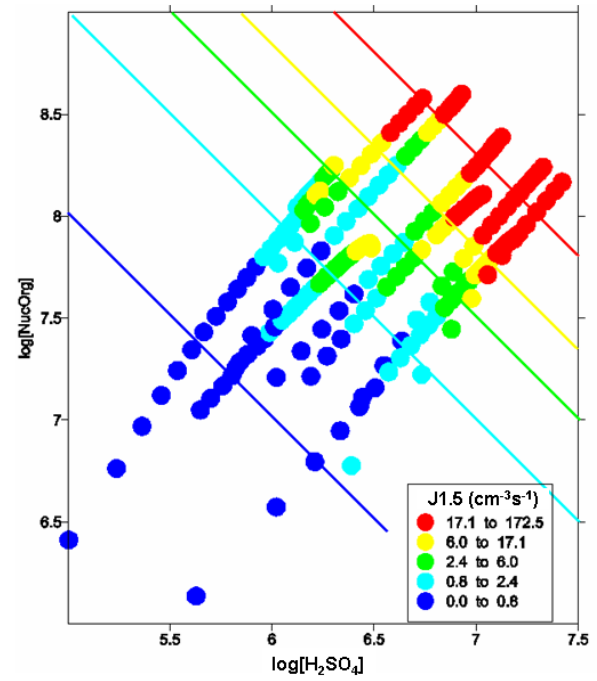
Fig. 5. Heterogeneous nucleation probability curves for the acti- Figure 5. Heterogeneous nucleation probability curves for the activation of differently vation of differently charged tungsten oxide (WO x ) particles with charged tungsten oxide (WO x ) particles with mean electrical mobility diameter of 2.0 nm. mean electrical mobility diameter of 2.0nm. Negatively charged Negatively charged particles are activated at lowest vapor saturation ratios followed by particles are activated at lowest vapor saturation ratios followed by positively charged particles and neutral ones clearly indicating a positively charged particles and neutral ones clearly indicating a charge and sign charge and sign preference for the heterogeneous nucleation at this preference for the heterogeneous nucleation at this particle size. Figure 4. Isopleth plot of J (cm –3 s –1 ) as a function of log[H SO ] versus log[NucOrg]. Fig. 4. Isopleth plot of J 1 . 5 (cm − 3 s − 1 ) as a function of 1.5 2 4 particle log[H 2 SO 4 ] versus log[NucOrg]. The iso-lines are drawn to guide The iso-lines are drawn to guide the eye. If J depended on either H SO or NucOrg the eye. If J 1 . 5 depended on either H 2 SO 4 or NucOrg alone the 1.5 2 4 iso-lines would need to be horizontal or vertical, respectively. The alone the iso-lines would need to be horizontal or vertical, respectively. The diagonal iso- diagonal iso-lines clearly show that the data can only be explained with a dependence of J 1 . 5 from both H 2 SO 4 and NucOrg (from lines clearly show that the data can only be explained with a dependence of J from both Metzger et al., 2010, Supporting Information). 1.5 H SO and NucOrg (from Metzger et al., 2010, Supporting Information). 2 4